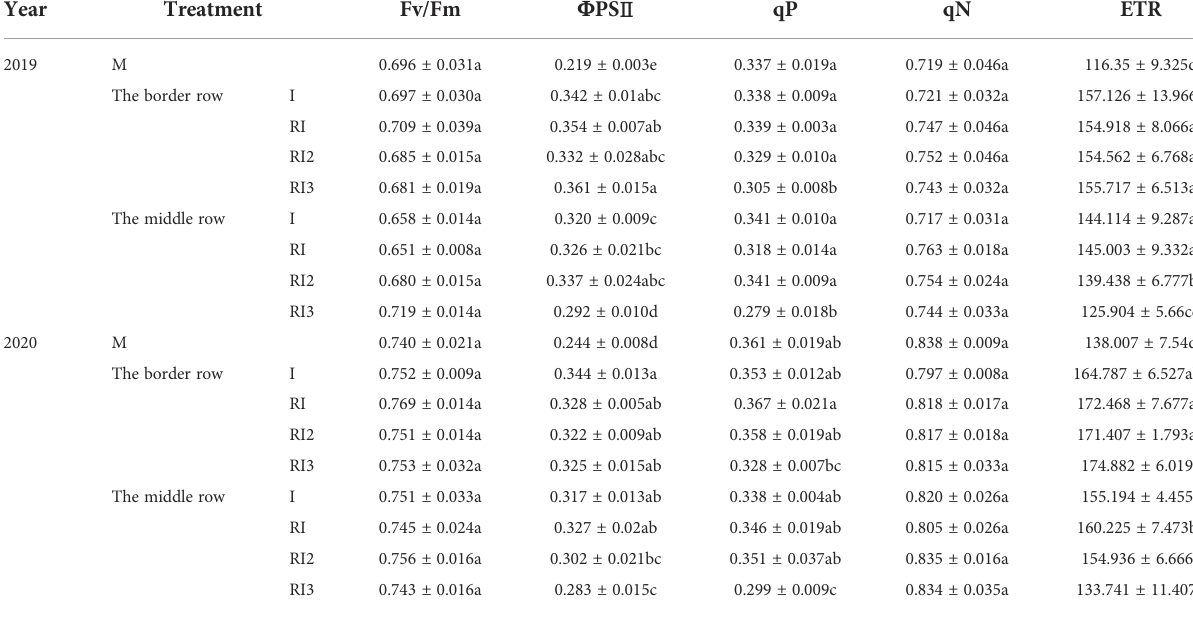
TABLE 4 The chlorophyll fl uorescence characteristics of